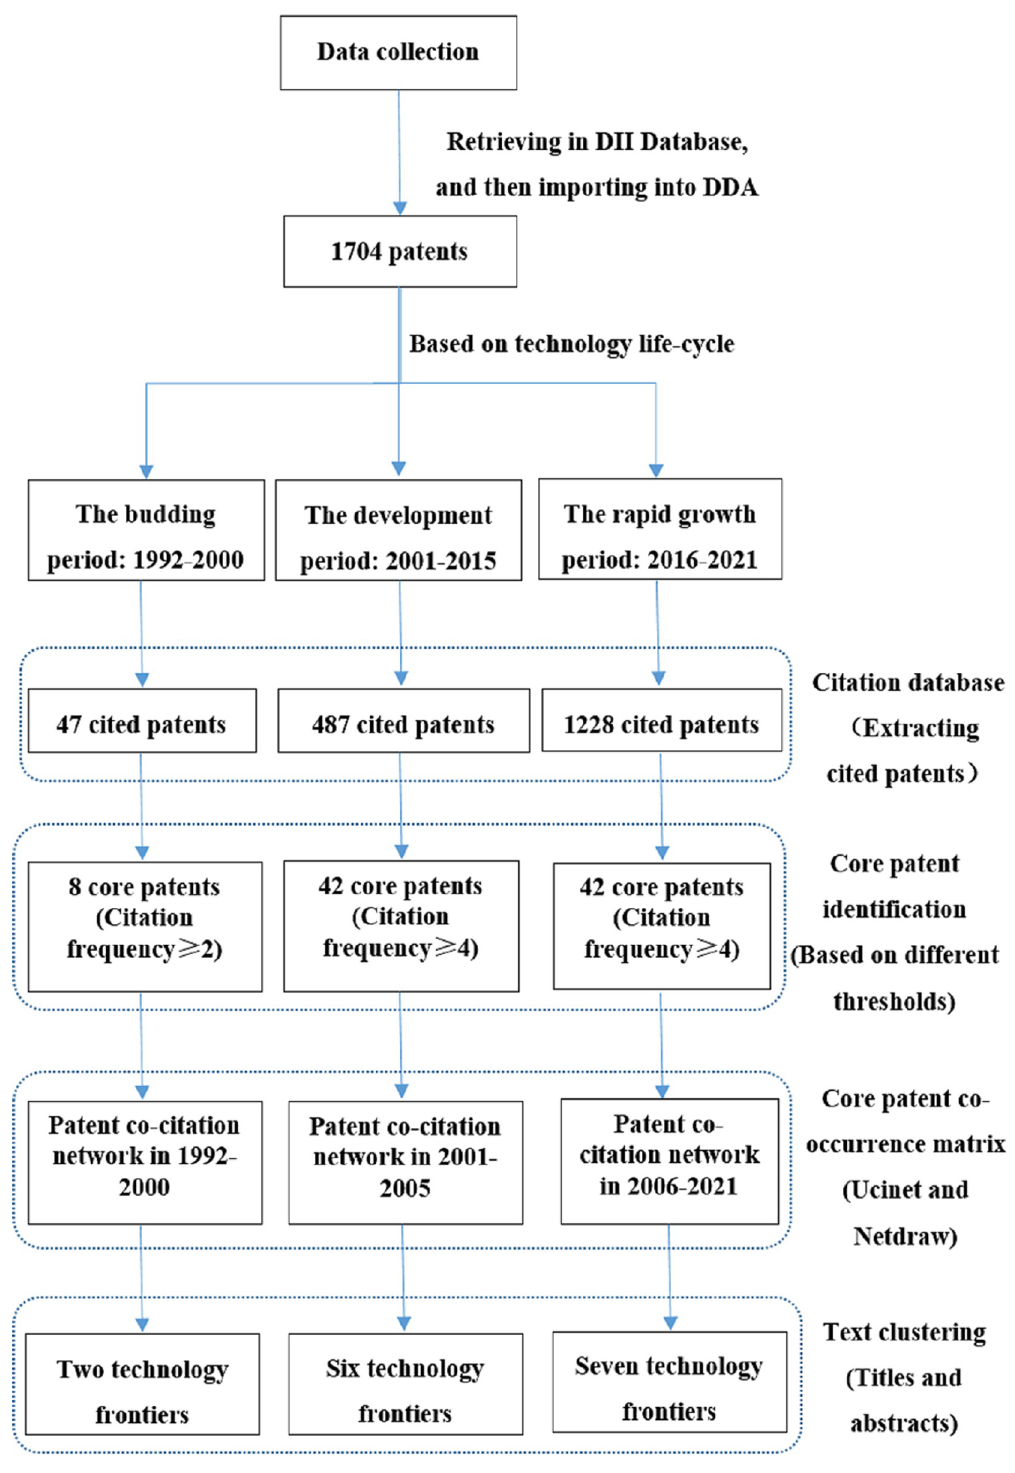
Fig 1. The whole analysis